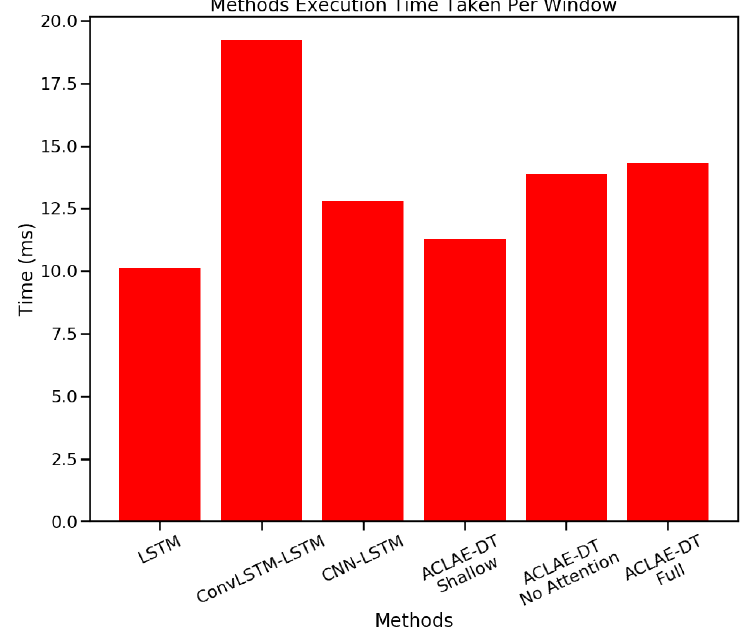
Figure 8. Execution time taken per window.